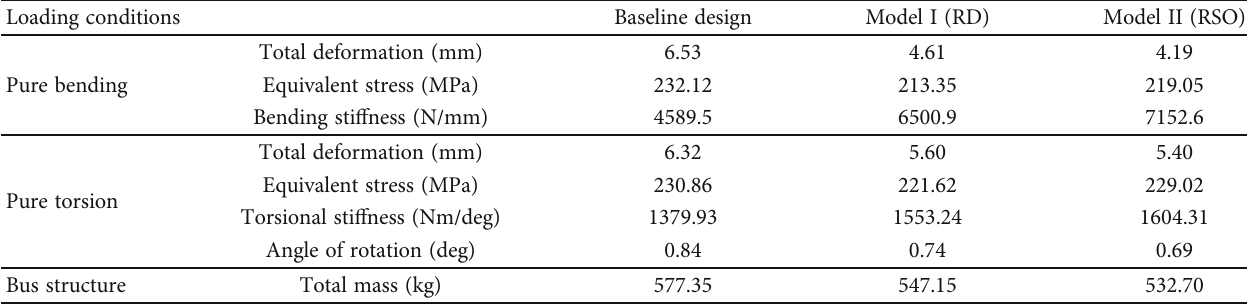
Table 8: Comparison of the original, reinforced, and optimal models in two loading